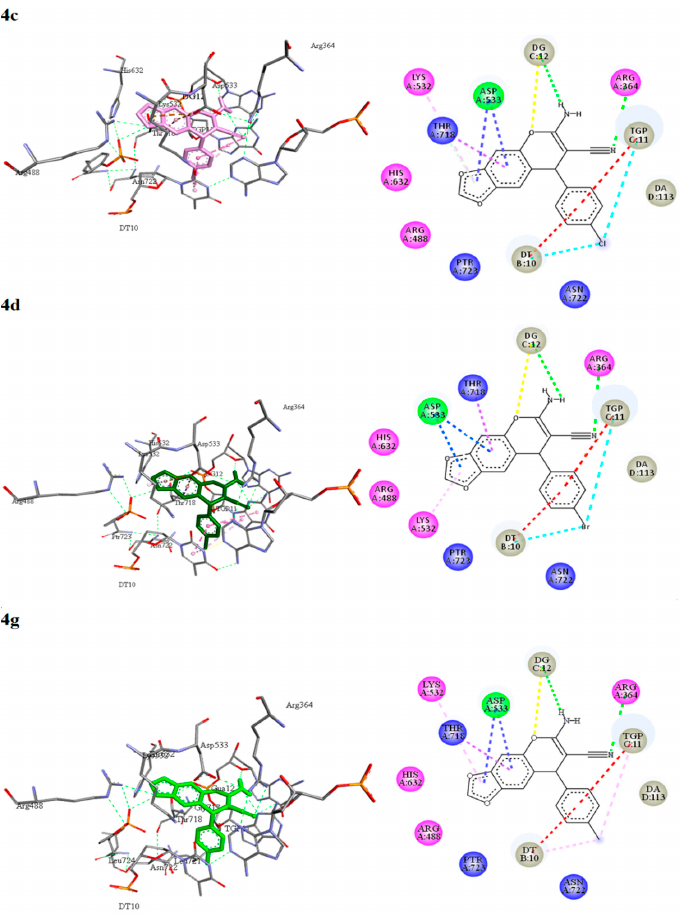
Figure 2. Schematic representation of the binding mode of 2-amino-3-cyano-6,7-methylendioxy-4 H - chromenes 4a , 4b , 4c , 4d and 4g and topotecan ( 7 ) at the active site of topoisomerase I. The 3D mod- els portray the hydrophilic bonds and amino acid residues found in the active site of the enzyme. In the 2D models, the following types of interactions are denoted with dotted lines: conventional hydrogen bond (green), carbon–hydrogen (yellow), π –cation (orange), π –anion (blue), π –sigma (purple), π –alkyl (pink), π – π -stacked (red), π – π T-shaped (fuchsia), and halogen (cyan). The solvent accessible surface is illustrated for the amino acid residues and ligands. The amino acids are de- picted in pink (basic), green (acidic), yellow (hydrophobic) and blue (hydrophilic). The DNA resi- dues appear in gray.